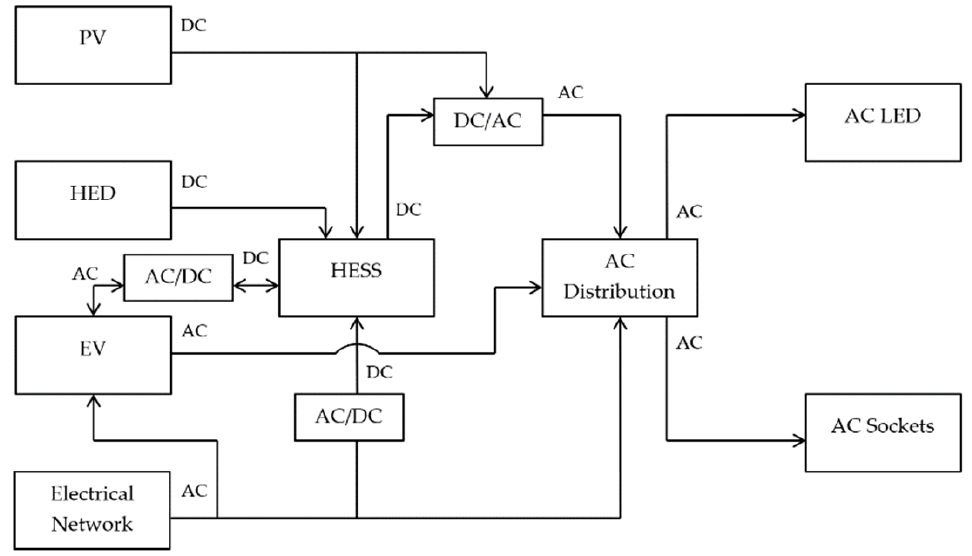
Figure 8. Block diagram of the current scenario with PV, HED, and EV.